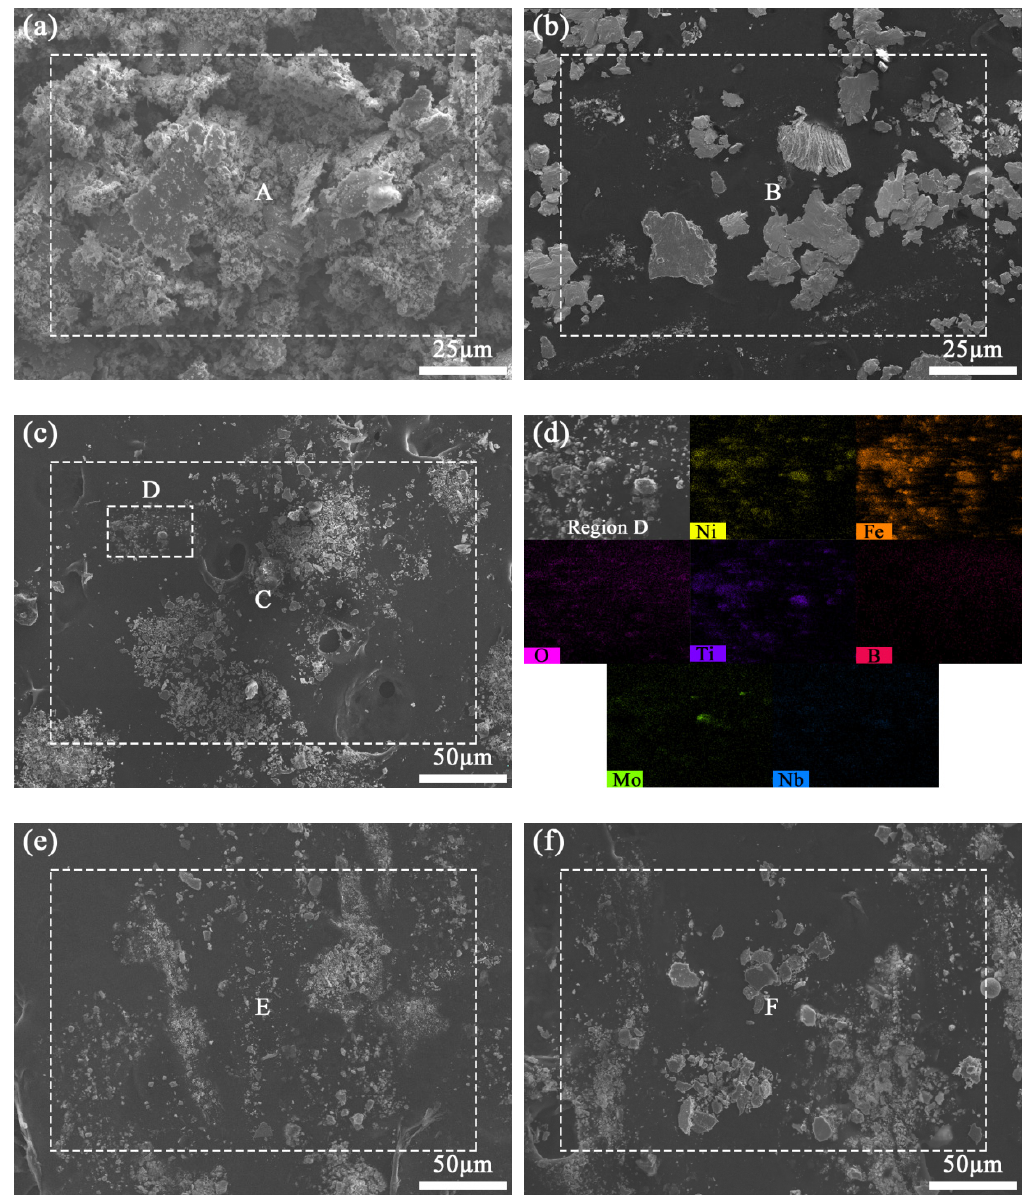
Figure 15. SEM images of the wear debris of coatings ( a ) TB0, ( b ) TB10 and ( c ) TB20, ( d ) EDS surface scanning analysis of region D, SEM images of the wear debris of coatings ( e ) TB30 and ( f ) TB40.